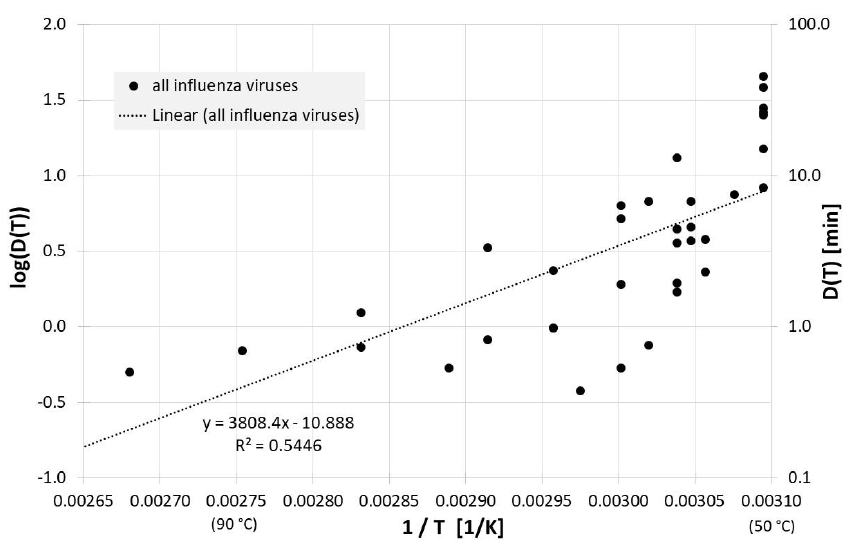
Figure 1. Correlation between 1/T and log(D(T)) for all published influenza virus thermal inactivation data in liquids other than animal foods or waste along with the linear regression curve. For better understanding, D(T) is also given on the right Y-axis in a logarithmic scale. Due to the scatter of the data, the most often investigated liquids PBS (phosphate buffered saline), allantoic fluid and cell culture medium were also analyzed separately.